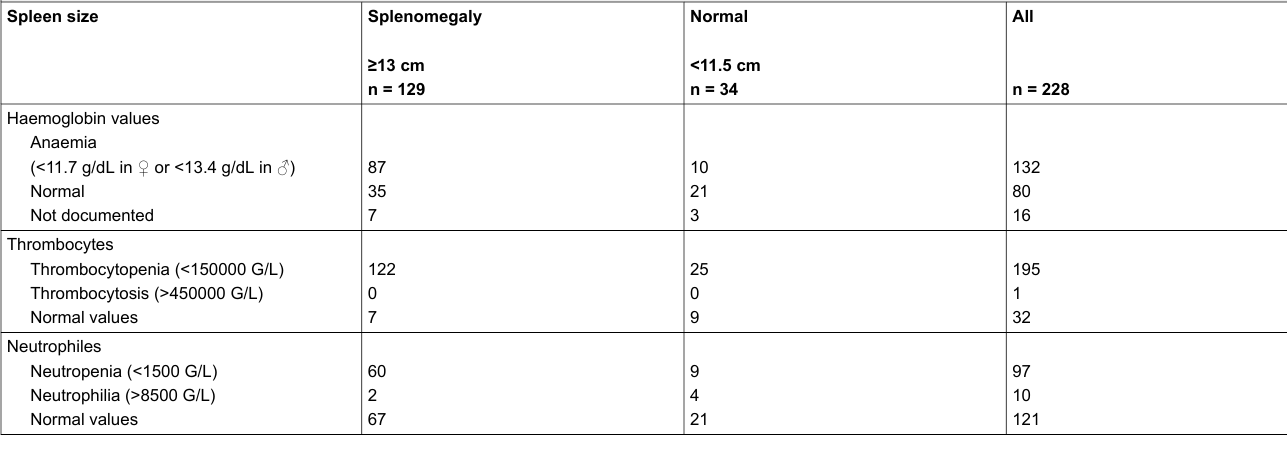
Table 1: Clinical presentation of patients with splenomegaly, normal size spleen and the whole patient cohort evaluated by the epinephrine stimulation test: spleen size and peripheral blood count before epinephrine stimulation test. Our patient cohort also comprised 27 patients with borderline size spleen (≥11.5 cm but <13 cm) as well as 38 patients without documented spleen size.